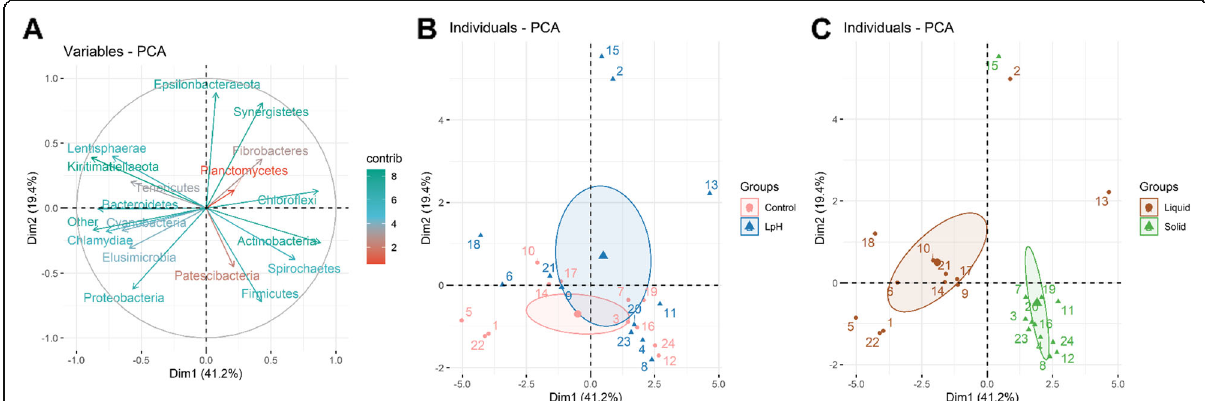
Fig. 2 Principal component analyses (PCA) of overall bacterial composition among all samples at the phylum level. Variable contributions to the first two components are labelled with different colors ( a ). All variables were represented by arrows, and individuals were represented by points with numbers. Points were colored by treatment group ( b ) or ruminal sample fraction group ( c ). All the sequence counts were transformed to centered log ratios before PCA analyses